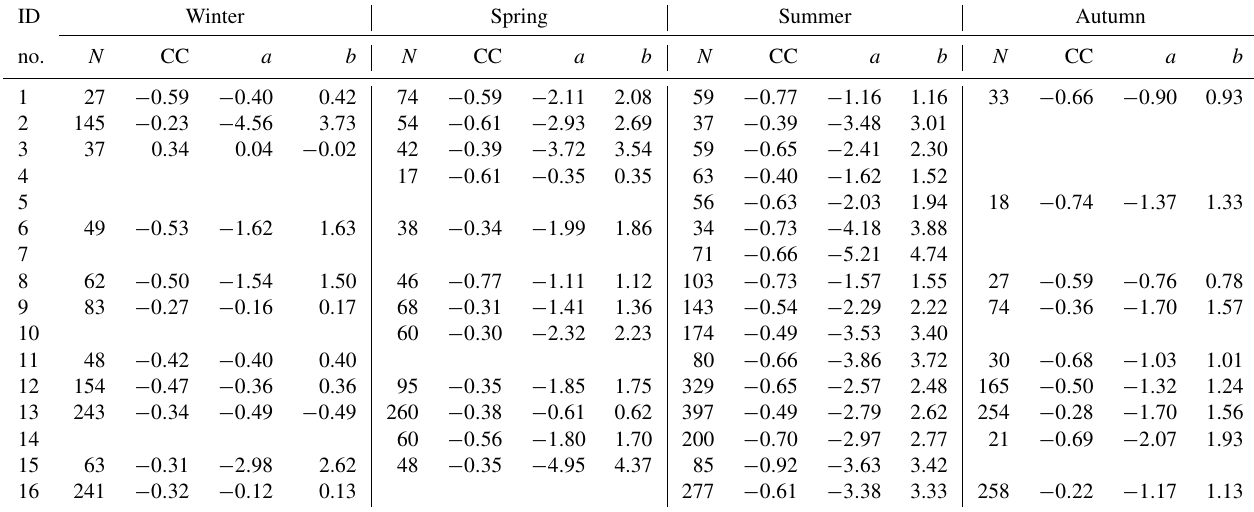
Table 3. Number of cloud-free days ( N ), correlation coefficient (CC), slope ( a ), and intercept ( b ) of the affine functions for each season between SDF and AOD following the ID number of the station from Table 1. Only values for statistically significant relationships are